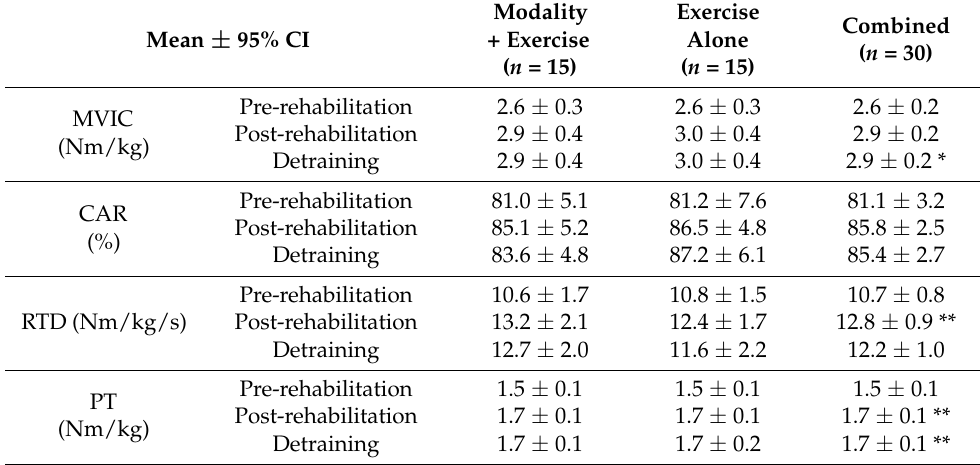
Table 3. Changes in quadriceps function.